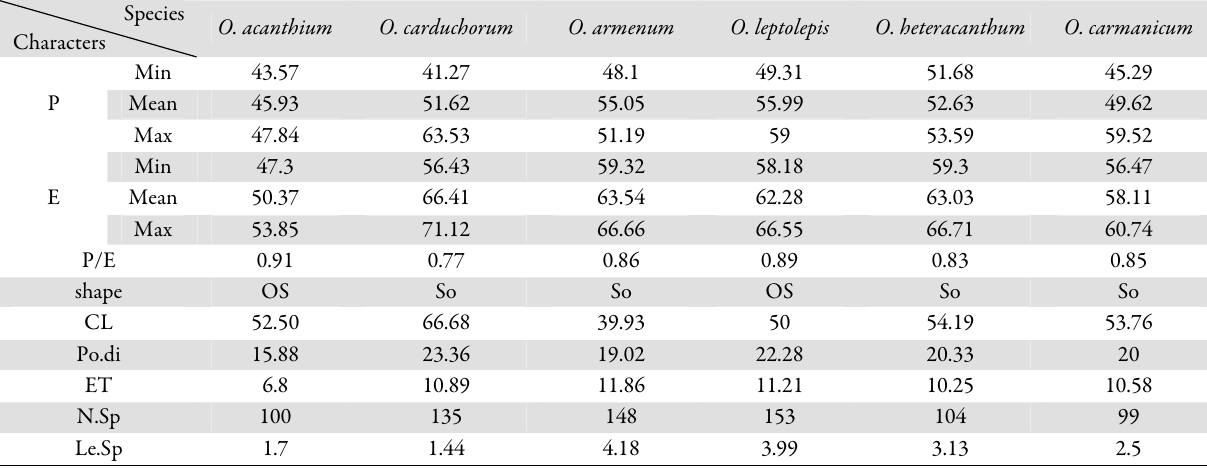
Tab. 6. Tabular summary showing the pollen grains dimensions (The unit is micrometer). P: Polar axis, E: Equatorial axis, Cl: Colpus Length, Po. Di: Pore Diameter, Et: Exin Thickness, N. Sp: Number of Spines, Le. Sp: Length of Spines, OS: Oblate Spheroidal, SO: Suboblate. Species